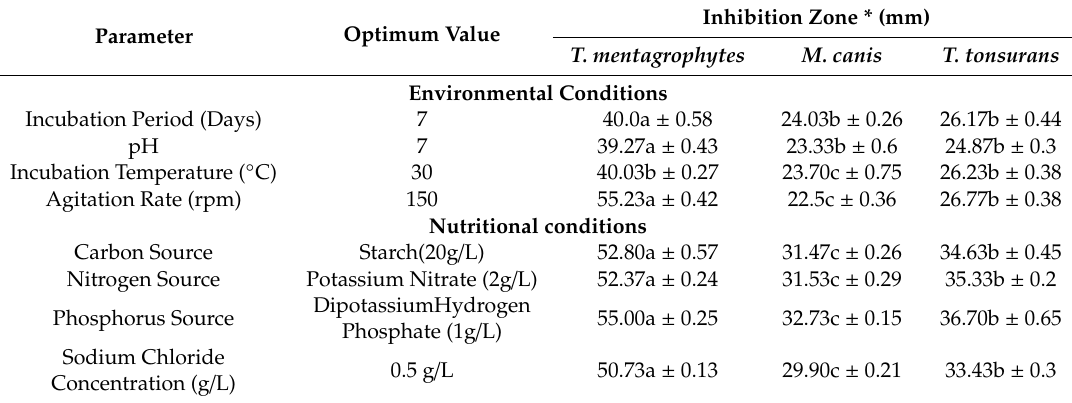
Table 2. The selection of optimum conditions necessary for anti-dermatophytic substance production by S. atrovirens .